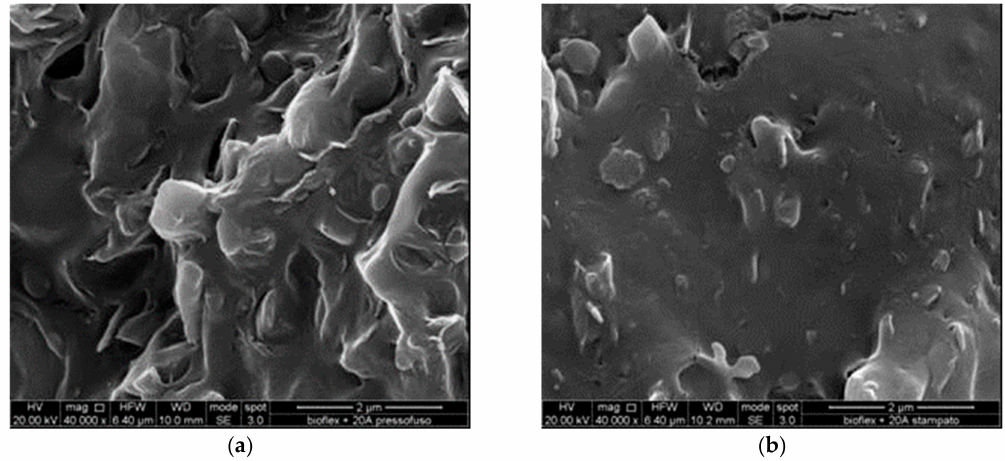
Figure 6. ( a ) SEM fracture surfaces of B+CL-CM sample; ( b ) SEM fracture surfaces of B+CL-IM